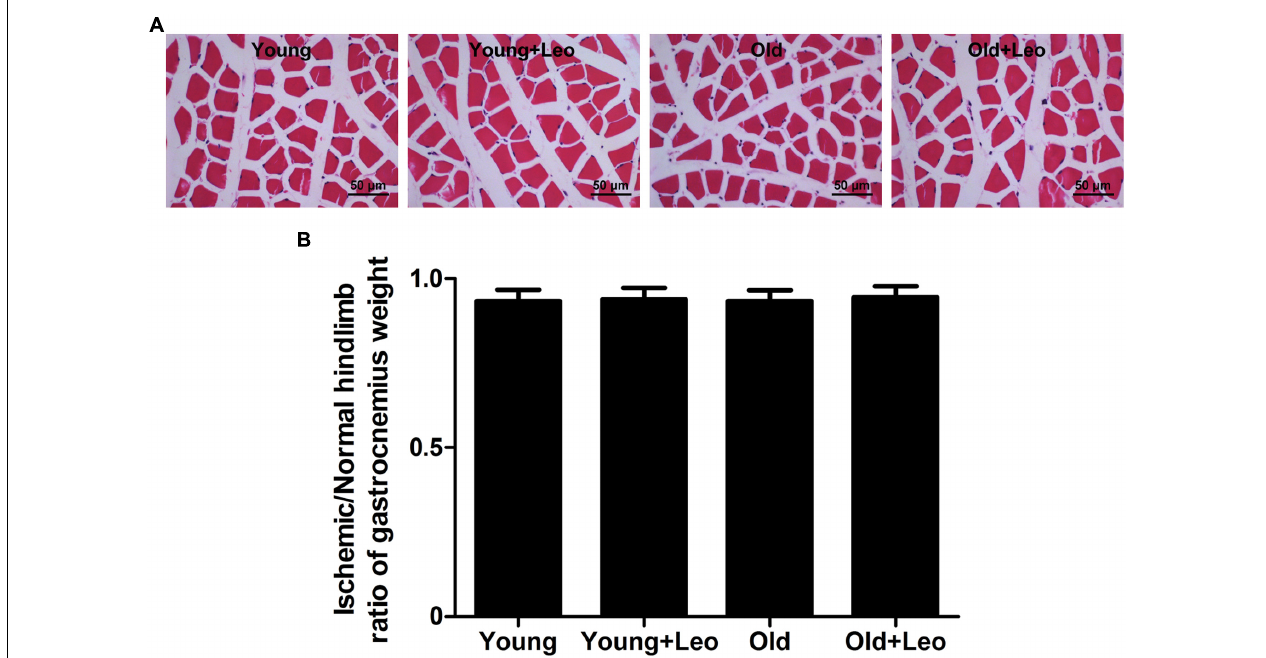
FIGURE 3 | H&E-staining of ischemic hindlimb muscles of different groups. (A) Representative H&E-staining images. Scale bar = 50 µ m. (B) Weight of left (ischemic) gastrocnemius muscle normalized to